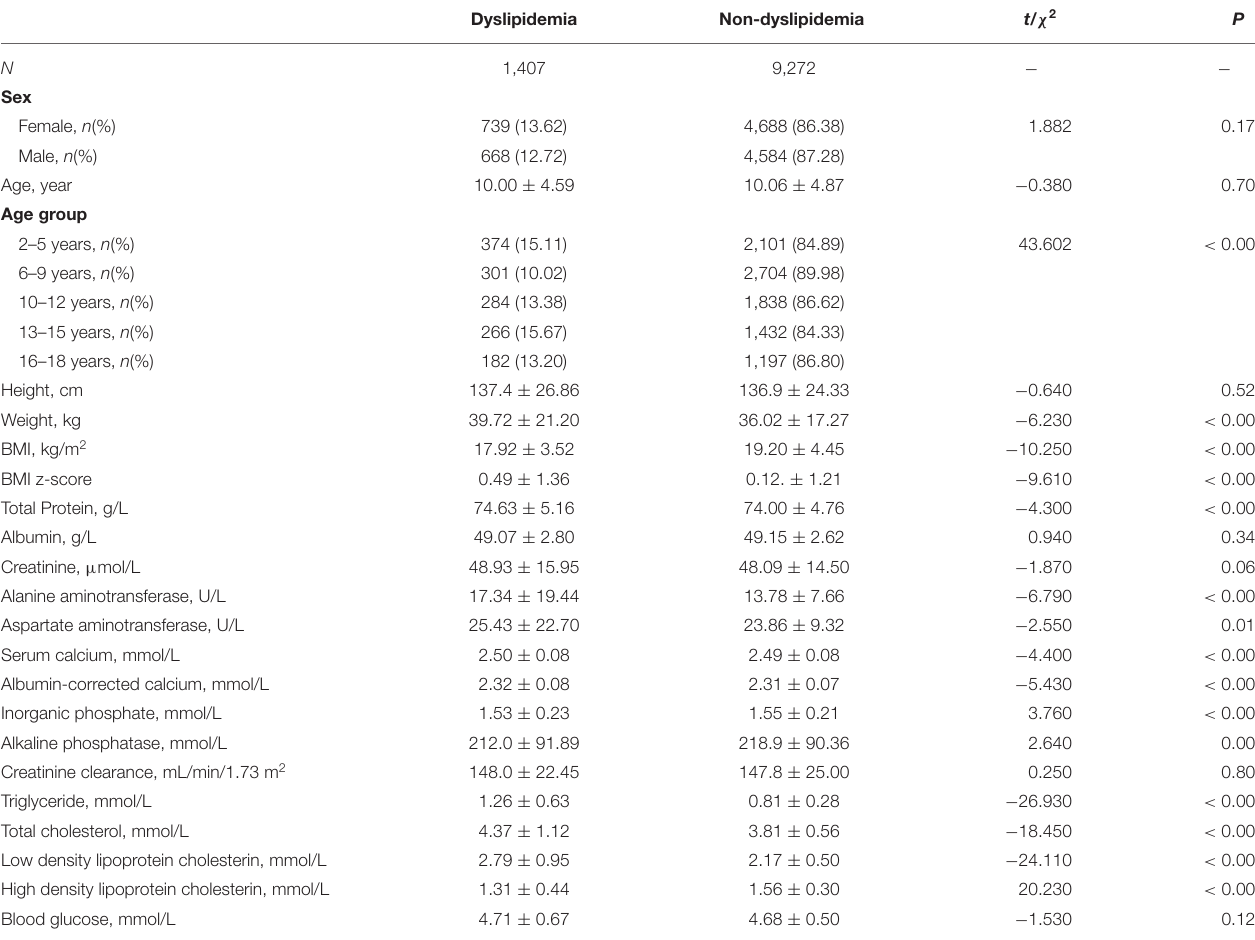
TABLE 2 | Comparisons between normality and dyslipidemia.